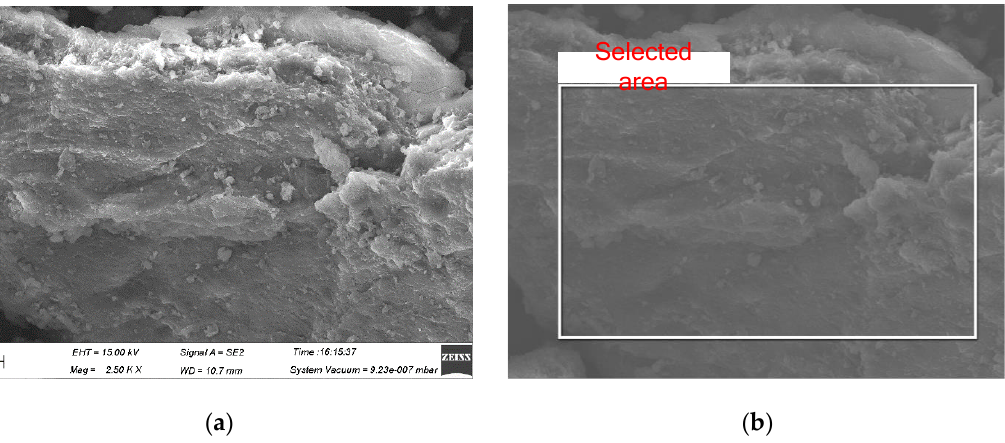
Figure 3. Characteristic test of a gangue sample element. ( a ) Morphological characteristics of gangue sample; ( b ) Area selected to be analyzed by X-ray energy spectrum.